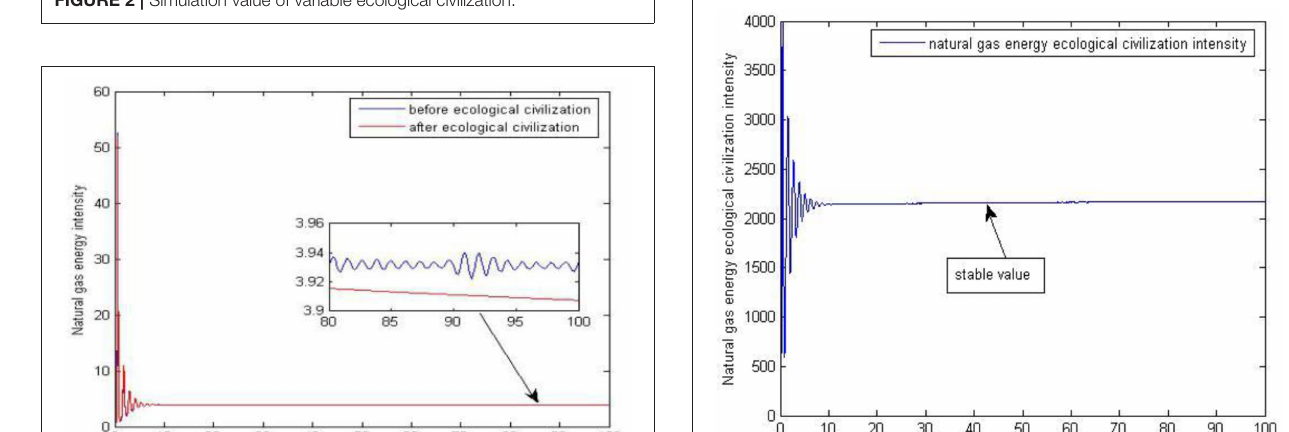
FIGURE 2 | Simulation value of variable ecological civilization.